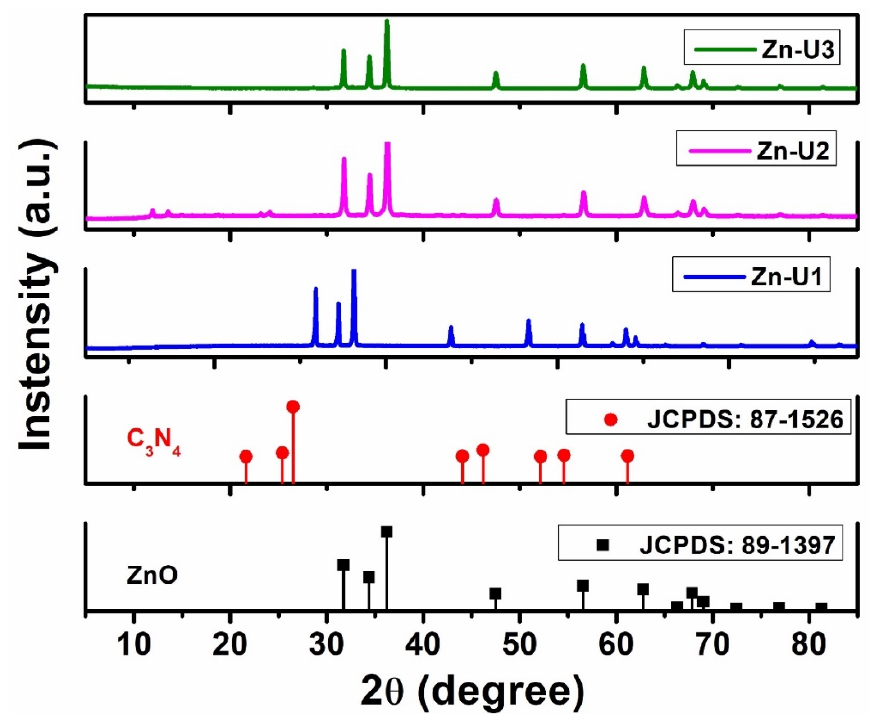
Figure 1. XRD patterns of the Zn-U1 Zn-U2 and Zn-U3 nanocomposites.